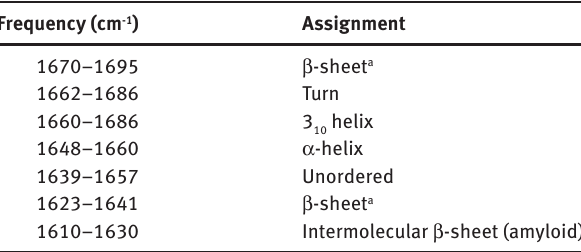
Table 2 Correspondence between amide-I peak frequencies and secondary structure